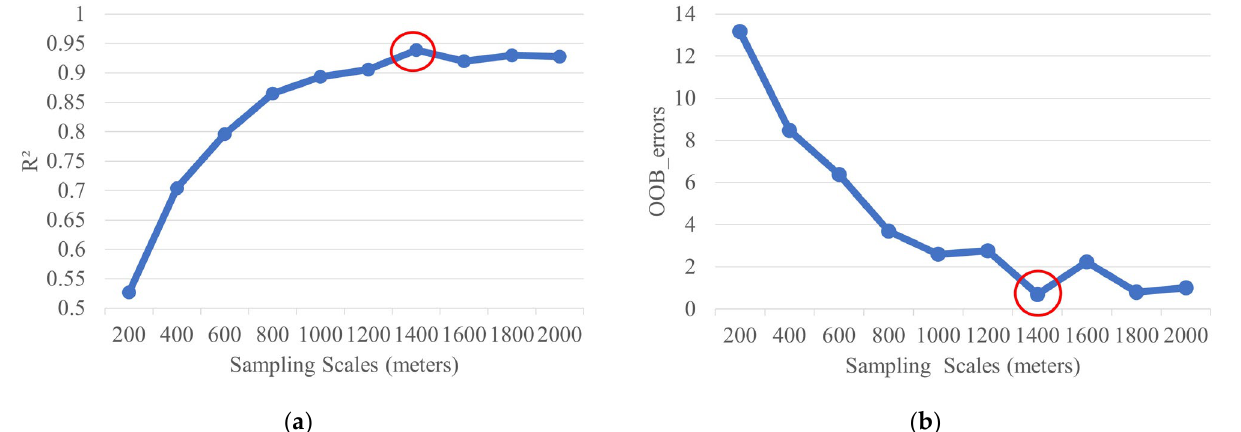
Figure 6. ( a ) The dynamic changes of the regression coefficients (R 2 ) with increasing the scale; ( b ) The dynamic changes of the out-of-bag (OOB) error with increasing the scale. Both OOB error and R 2 are calculated by the random forest method.